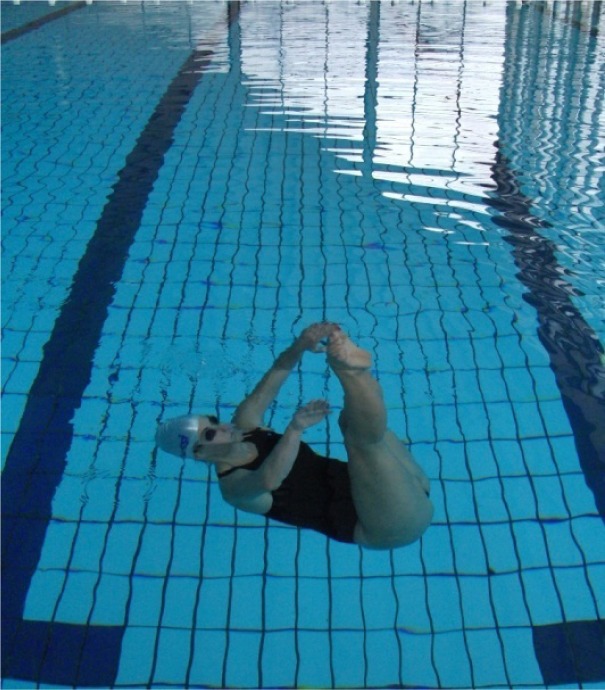
Barracuda performanceFigure 1a. Start positionFigure 1b. Finish position